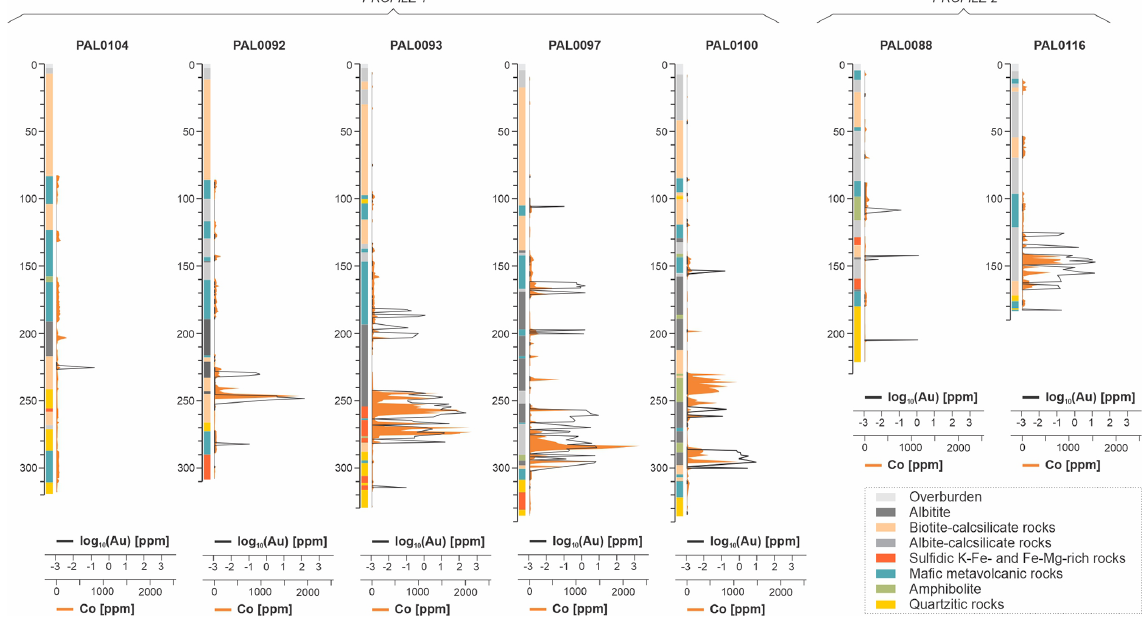
Figure 7. Downhole plots illustrating the distribution of Au (in log ppm) and Co (in ppm) along the stratigraphic column of sampled drill